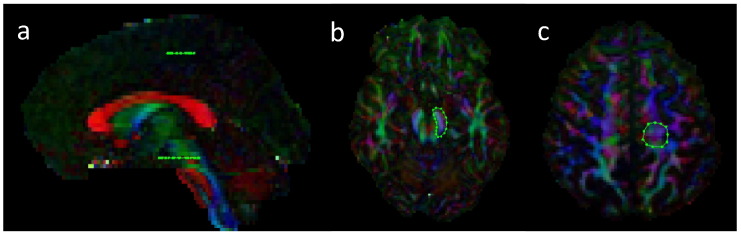
ROI placement for the corticospinal tract. ROI placement for the corticospinal tract (left hemisphere): a) sagittal view — both ROIs, b) axial plane — AND gate round the cerebral peduncle at the level of the decussation of the superior cerebellar peduncle, c) axial plane — AND gate round the motor cortex. The tract was split into inferior and superior segments at the level of the lateral sulcus.